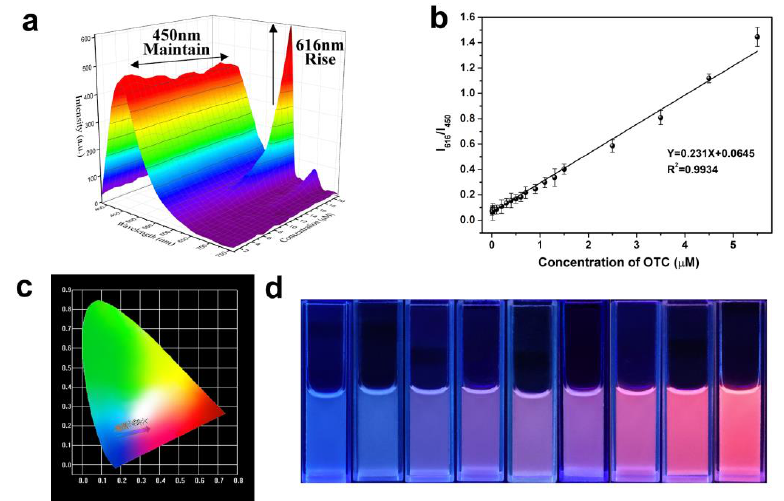
Figure 6. ( a ) The emission spectra of SiCDs@mMIP-cit-Eu in the presence of different OTC concentrations. ( b ) The fitting curve of SiCDs@mMIP-cit-Eu between the relative ratios of (I 616 /I 450 ) and OTC concentrations ranging from 0 to 5.5 μM, and the error bars represent the standard deviation from three parallel tests. ( c ) CIE chromaticity diagram showing the (x,y) fluorescent color coordinates of SiCDs@mMIP-cit-Eu with the OTC concentrations ranging from 0 to 5.5 μM. ( d ) The fluorescence images of SiCDs@mMIP-cit-Eu probe in the presence of 0, 0.1, 0.5, 1, 2, 2.5, 5, 10, and 20 μM OTC under a UV lamp at 365 nm.